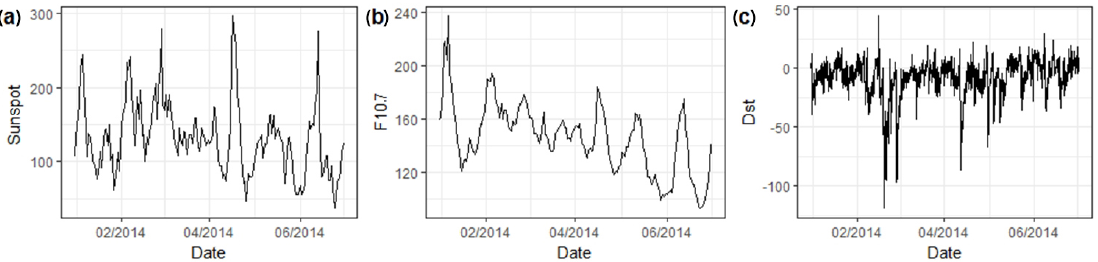
Figure 2. Variations in solar and geomagnetic indices with time. (a) Variations in sunspot index with time. (b) Variation in F10.7 index with time. (c) Variation in Dst index with